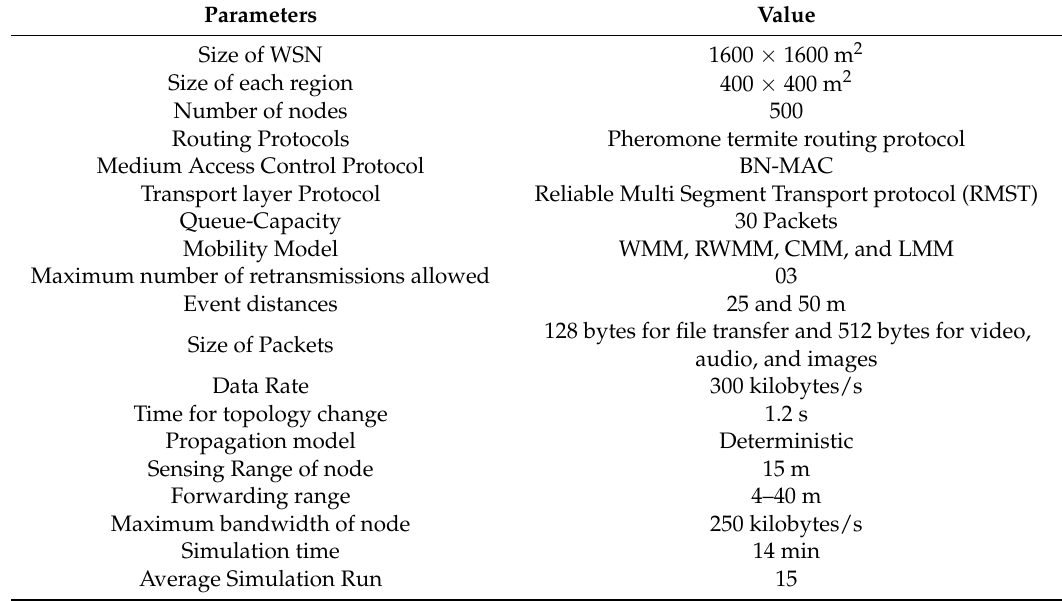
Table 2. Simulation parameters and corresponding